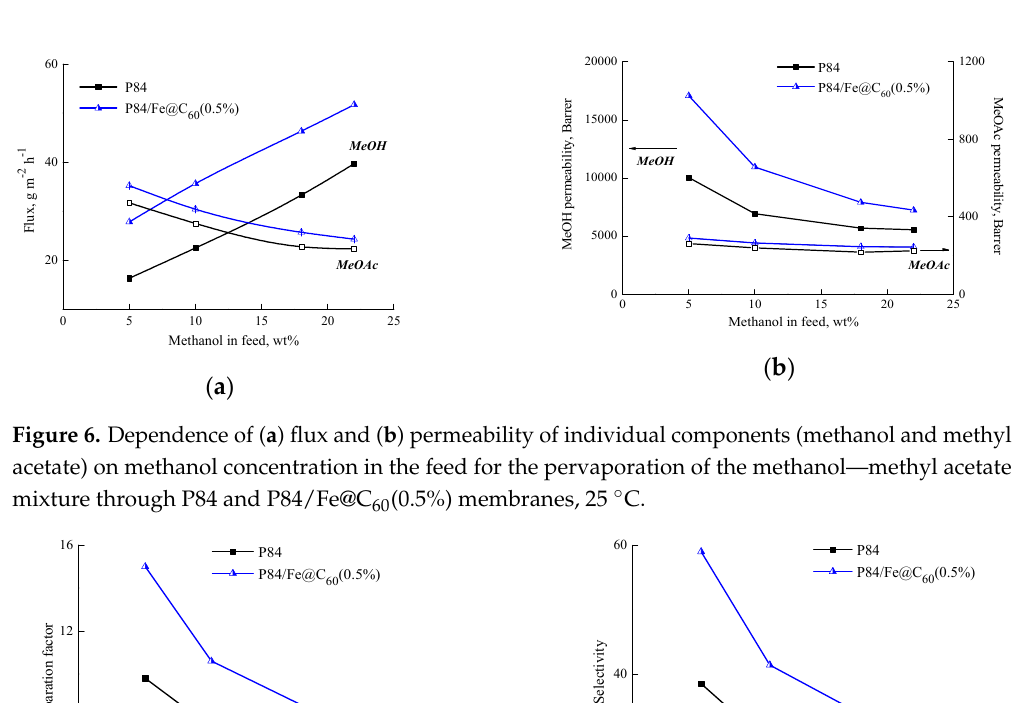
Figure 6. Dependence of ( a ) flux and ( b ) permeability of individual components (methanol and methyl acetate) on methanol concentration in the feed for the pervaporation of the methanol—methyl acetate mixture through P84 and Р 84/Fe@ С 60 (0.5%) membranes, 25 ° С .